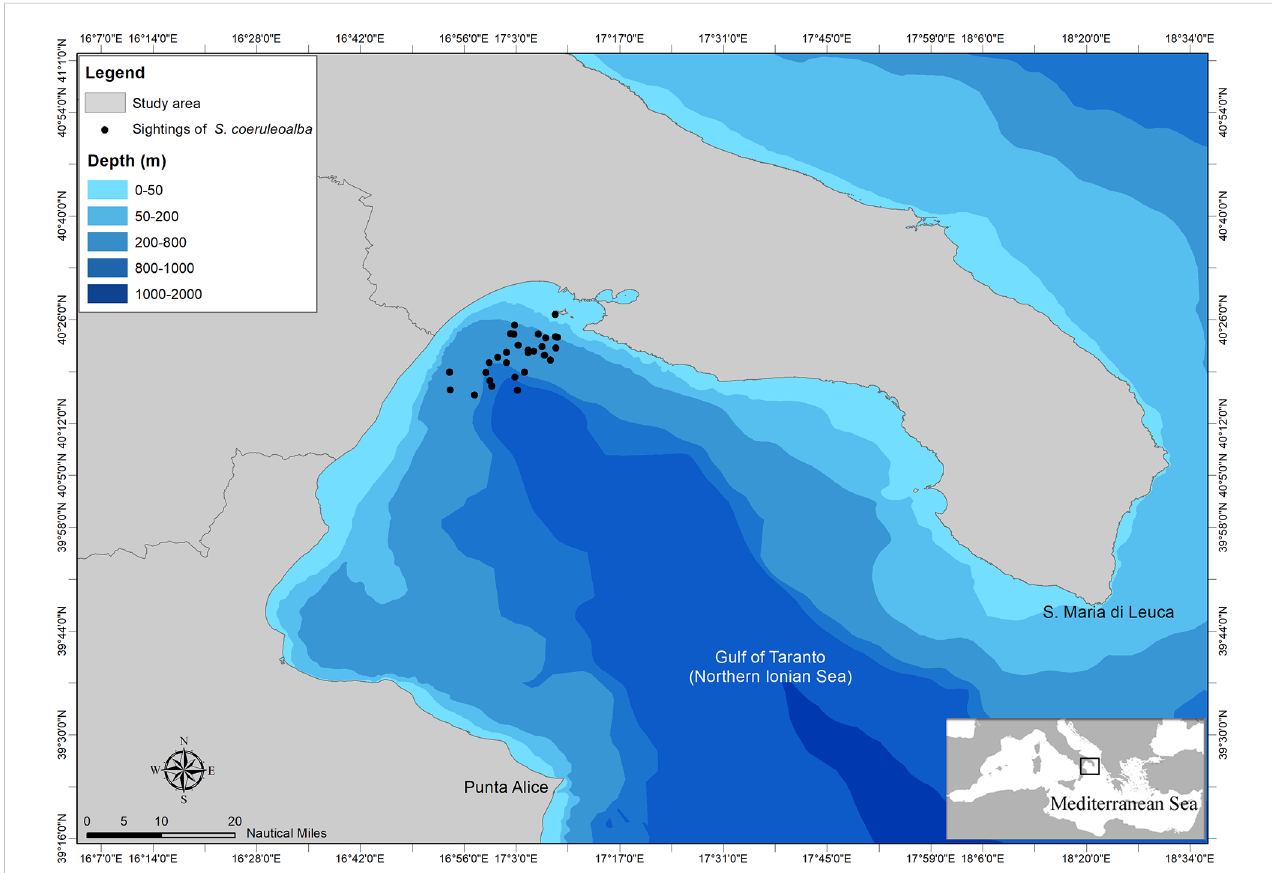
FIGURE 1 Map of the study area with indication of sightings of striped dolphin from which genetic samples were